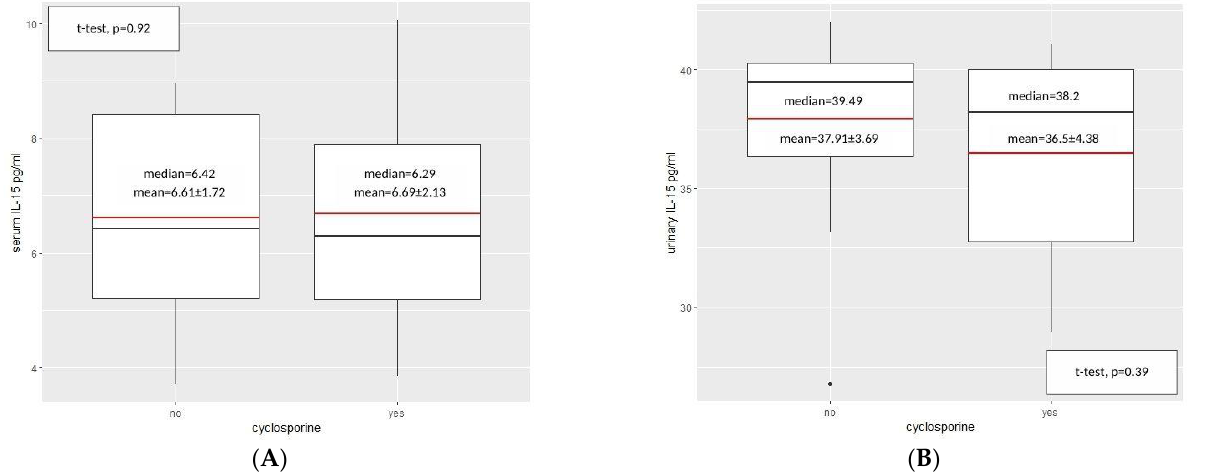
Figure 4. IL-15 concentration comparison in the study group in serum ( A ) and urine ( B ) between the patients on cyclosporine (yes) and treated with different drug (no), (Student’s t-test for independent samples). Red line represents mean value and black line represents the median.